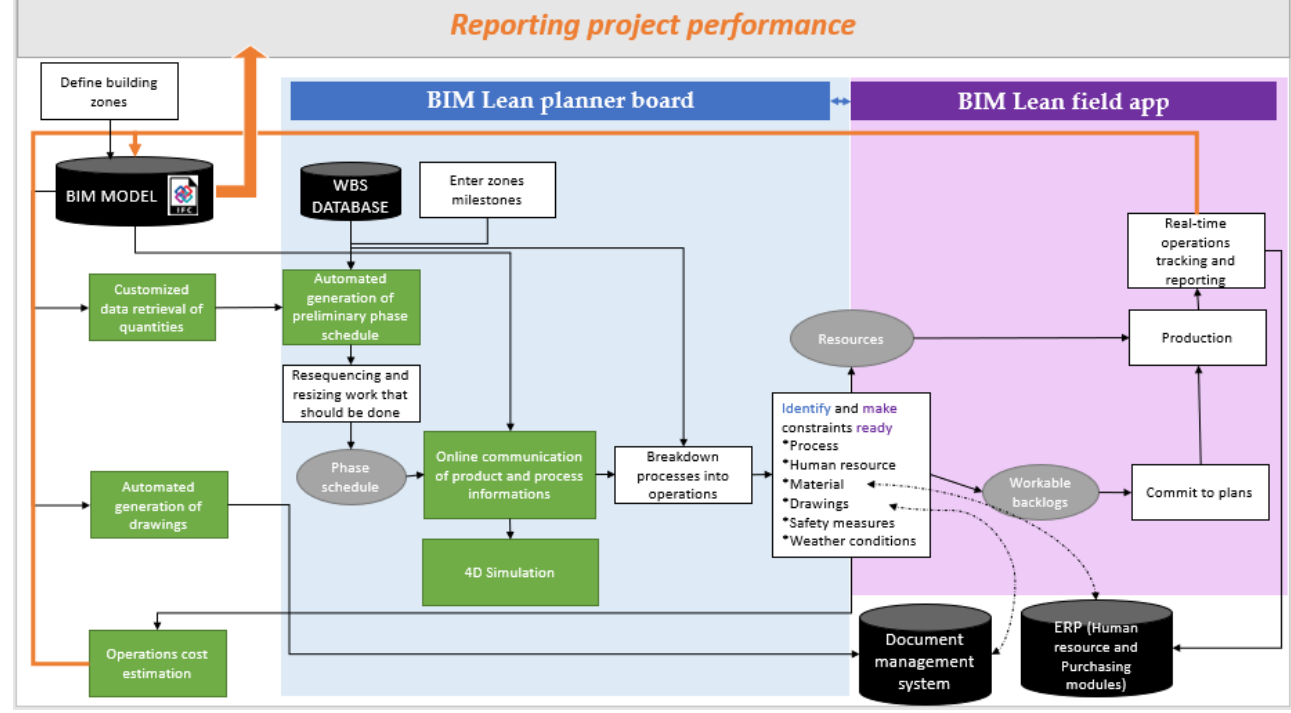
Figure 6. Detailed mapping of BIM functionality contributions along LPS process.